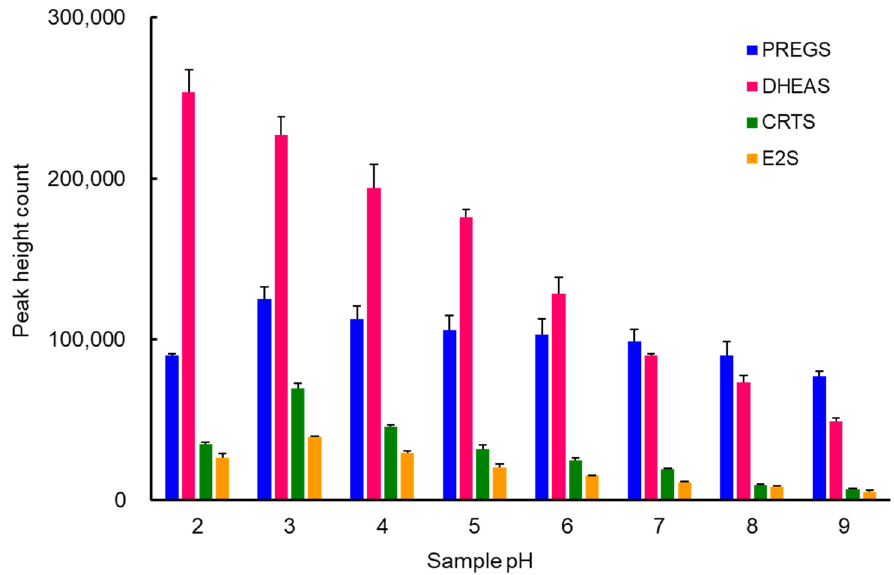
Figure 2. Effects of sample pH on the IT-SPME of sulfated steroid metabolites. Standard solution (40 μ L) containing 1 ng mL –1 each of PREGS, DHEAS, and CRTS and 5 ng mL –1 of E2S were extracted by 25 draw/eject cycles on a Supel-Q PLOT capillary at a flow rate of 200 μ L min –1 .